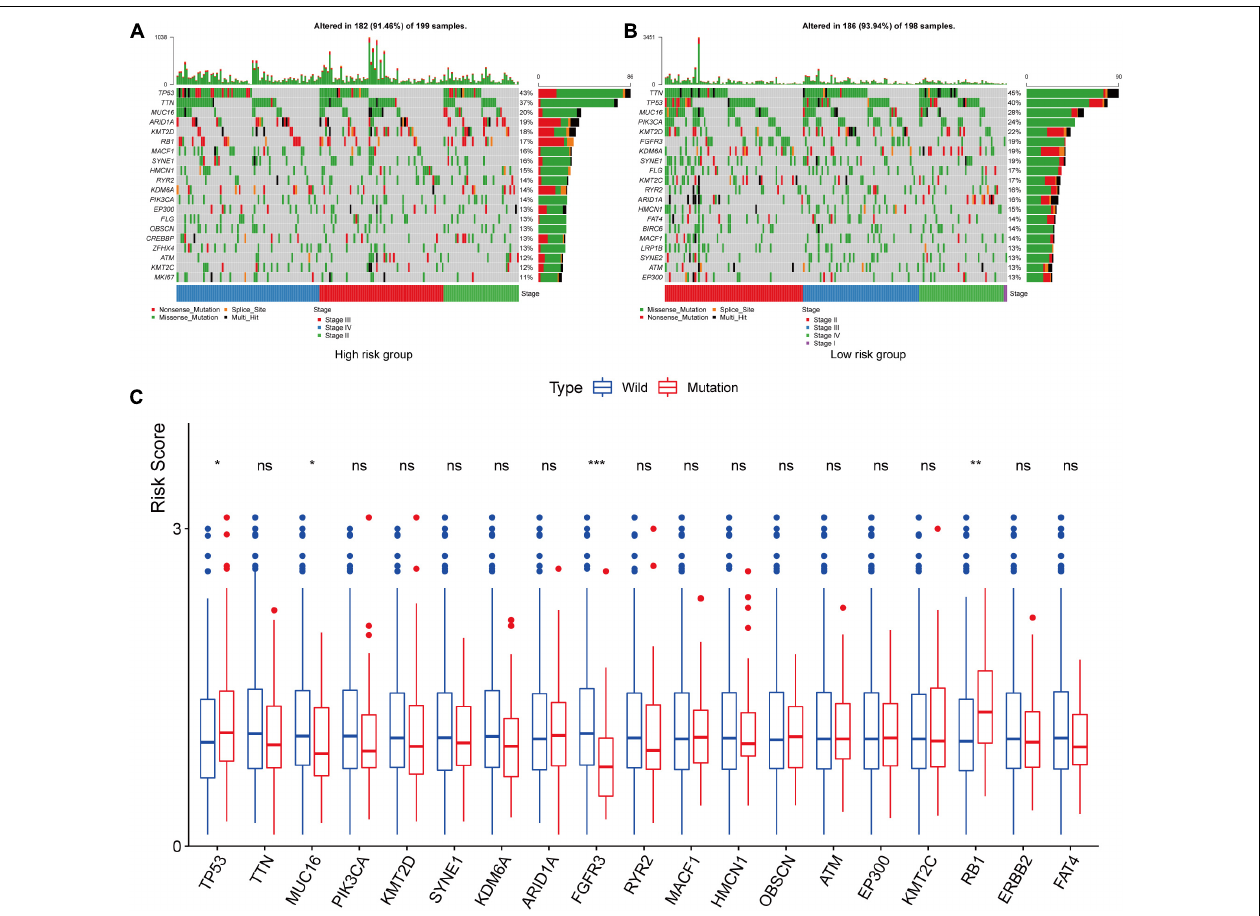
FIGURE 10 | Tumor mutational burden analysis. The top 20 mutational genes were listed in the high-risk group (A) and low-risk group (B) . The risk scores between the wild type and the mutation type of the top frequent mutational genes were compared (C) . The asterisk on the top of the box plots meant that the risk scores were significantly different between wild and mutational types. The risk scores in the mutational types of TP53 and RB1 were significantly higher than those in the wild types, while the risk scores were higher in the wild types of MUC16 and FGFR3 compared with the mutational types. * P < 0.05; ** P < 0.01; *** P < 0.001; ns, not